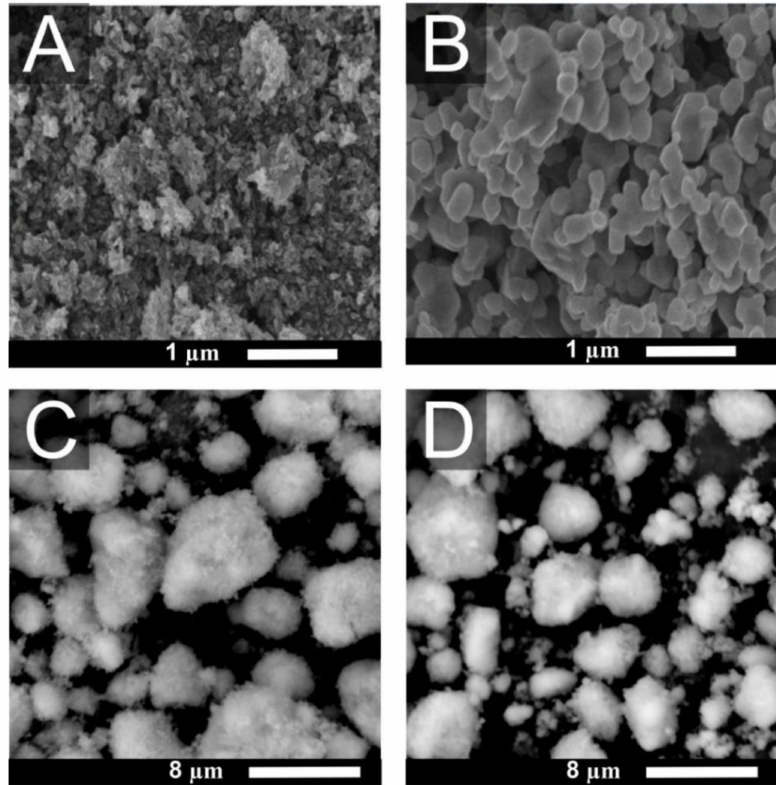
Figure 1. SEM micrographs of ( A ) Rutile 1, ( B ) Rutile 5, ( C ) Anatase, and ( D )